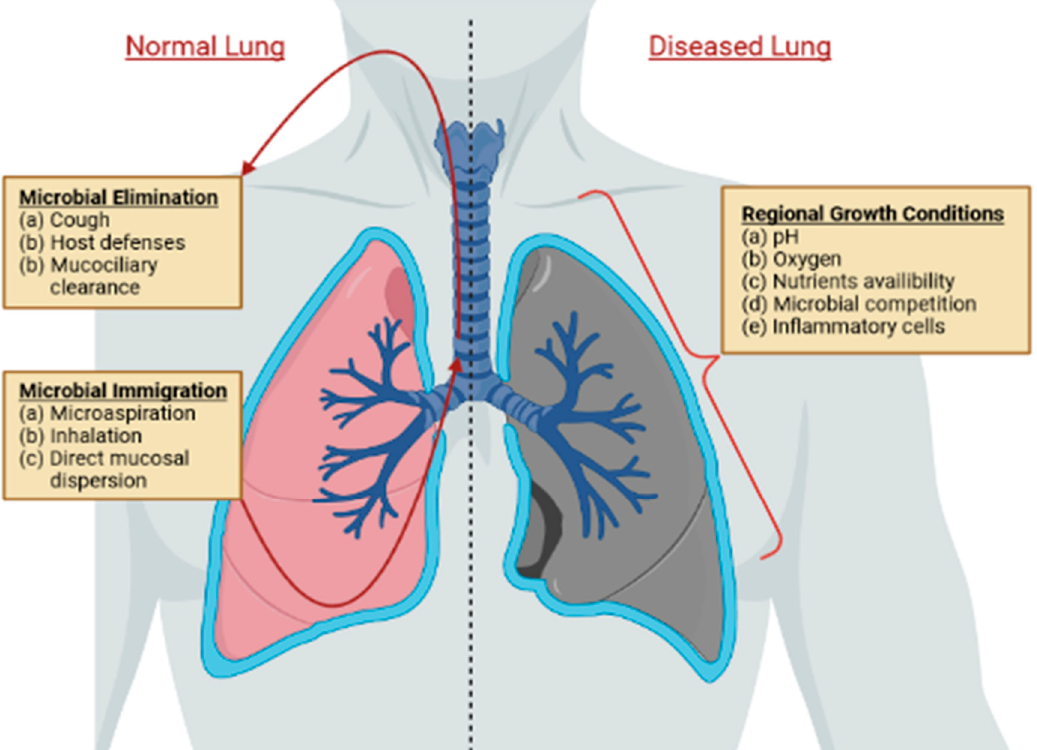
Figure 1. Three factors affecting the dynamics of host microbiota constitution in the lungs: immigration, elimination, and regional growth factors.